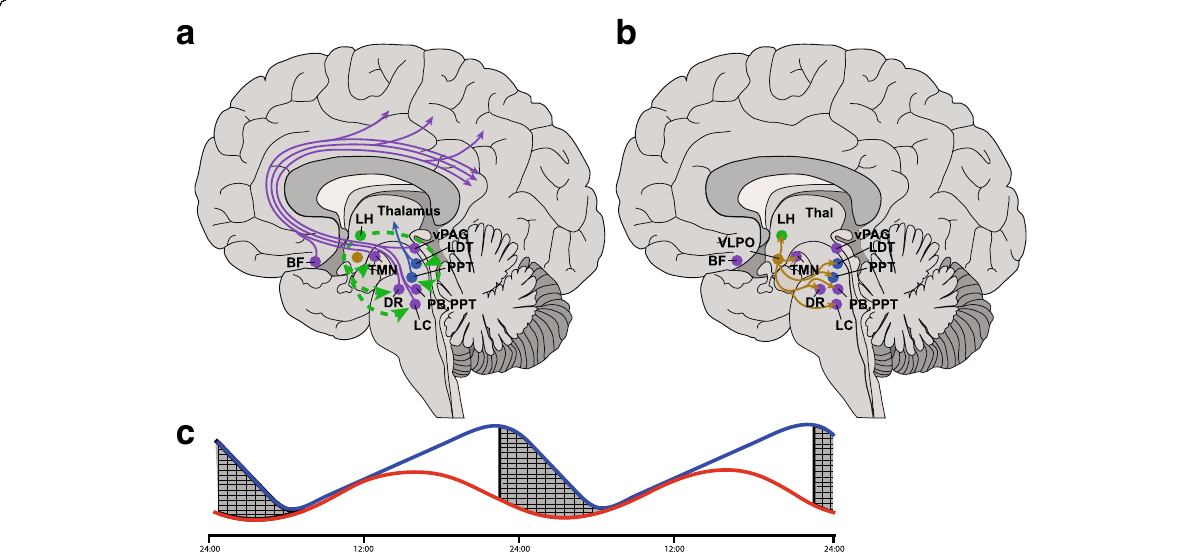
Fig. 1 Mechanisms regulating sleep wake modulation. a . Orexinergic neurons originating in the lateral hypothalamus (LH; Green) send excitatory projections to several brainstem nuclei that act to promote arousal. Ascending monoaminergic projections (purple) from the noradrenergic locus coeruleus (LC), glutamaterigic parabrachial (PB) and pedunculopontine (PPT), serotoninergic dorsal raphe (DR), dopaminergic ventral periaqueductal grey (vPAG), tuberomammillary nuceus (TMN) and GABAergic and cholinergic neurons in the basal forebrain (BF) diffusely innervate the cerebral cortex to promote arousal. There are also cholinergic projections (Blue) from the laterodorsal tegmental nuclei (LDT) and PPT nuclei that project to the thalamus to promote arousal. b . GABAergic ventrolateral preoptic (VLPO) neurons (Brown) act to inhibit the majority of the arousal nuclei, including LH orexinergic neurons to promote sleep. c . Homeostatic sleep pressure (Blue line) increases through wakefulness, likely via the accumulation of endogenous somnogens such as adenosine that excites VLPO neurons to promote sleep. This is combined with circadian sleep regulation (Red line) to create a balanced sleep wake cycle that is entrained to external environmental conditions. The circadian component is in part dependent on pituitary adenylate cyclase-activating peptide signalling within the hypothalamic suprachiasmatic nucleus as demonstrated by preclinical